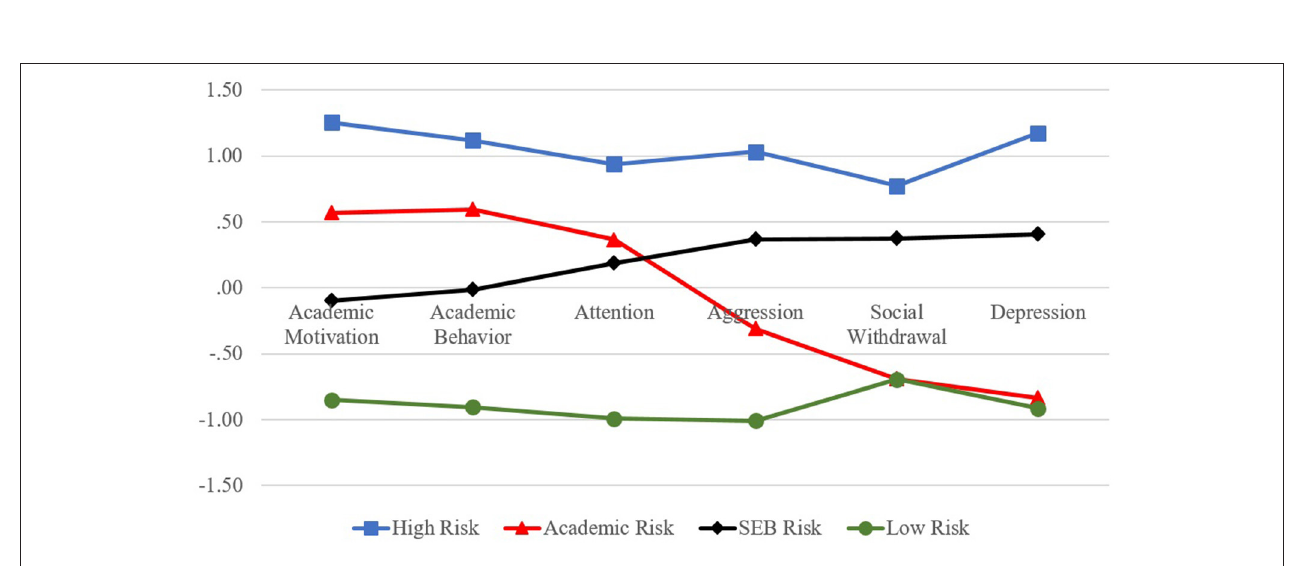
FIGURE 1 | Risk profiles of Korean adolescents.